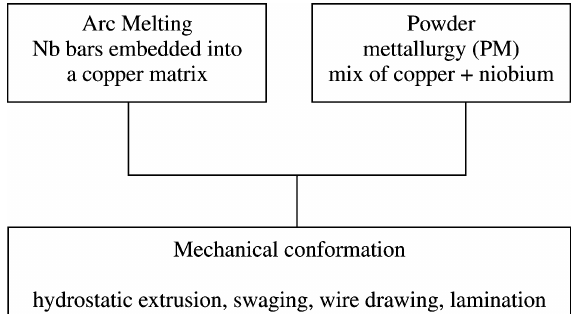
Figure 1. Fluxogram of the routes of copper-niobium wires